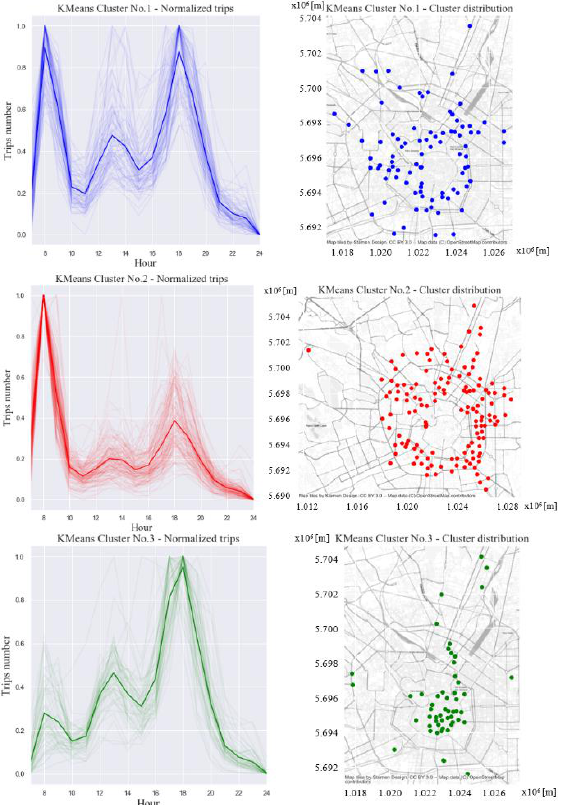
Figure 16. K-Means (k=3) over the normalised departures from the stations.